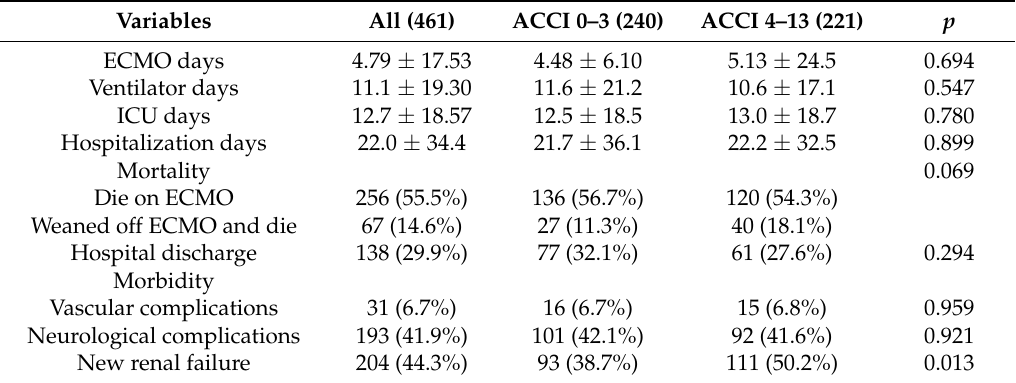
Table 2. Outcome analysis of ECPR. Data are presented for all patients and grouped by ACCI before ECPR.